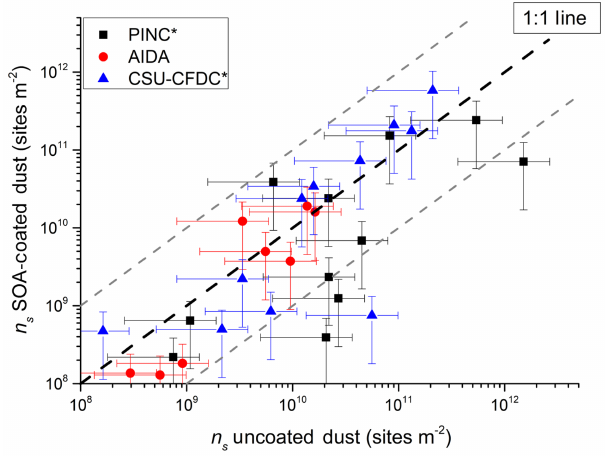
Figure 9. Comparison of ice nucleation activity of uncoated dusts with coated dusts distinguished by the three cloud chambers used in this study. Data are binned by temperature into 1K bins for each cloud chamber. The grey dashed lines represent a factor of 5 from the 1:1 line. Error bars in n s represent a relative uncertainty in siz- ing and counting particles of 76% (upper estimate).